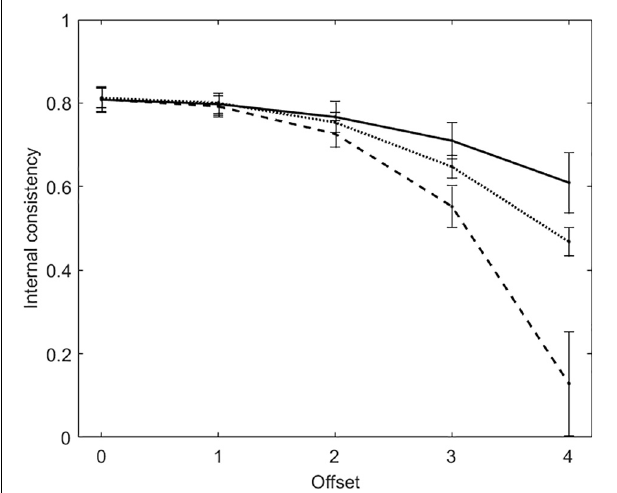
The dichotomous and polytomous tests are not directly comparable, even if they contain the same number of